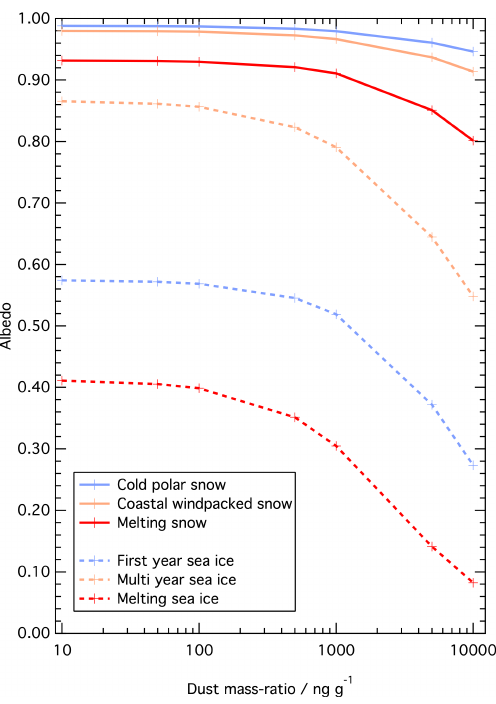
Figure 7. Albedo of three snow and sea ice types with increasing Asian dust mass ratio at 550nm. Snow thickness: 40cm, first-year sea ice: 80cm, multi-year and melting sea ice: 250cm.